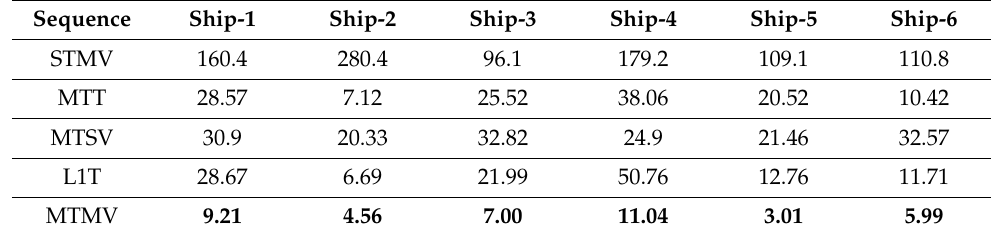
The bold indicates that the experimental value of this algorithm is superior to other algorithms. Table 2. Weighted standard deviation between the results of the five comparison methods and the real position (pixels). Sequence